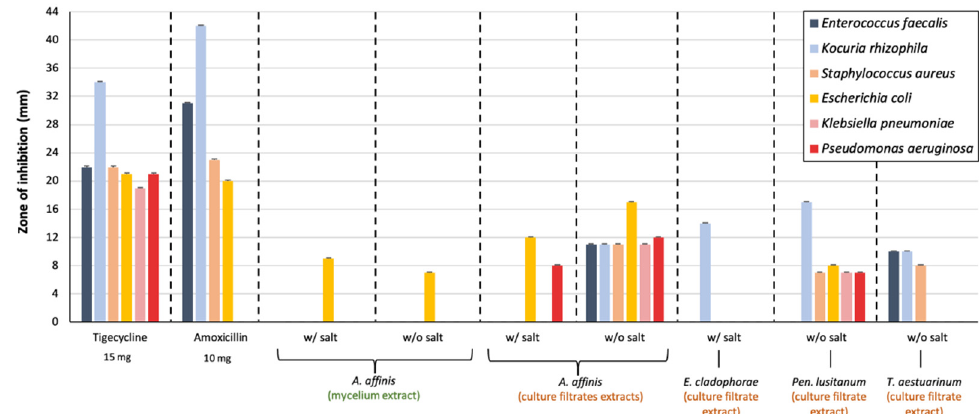
Figure 2. Antibacterial activity of the mycelium and culture media extracts of A. affinis (CMG 70), E. cladophora (MUM 19.33), Pen. lusitanum (MUM 18.49) and T. aestuarinum (MUM 19.05) using the disk diffusion assay. Data are shown as average ( n = 3) ± standard error. Extracts not inducing inhibition halos were not included.